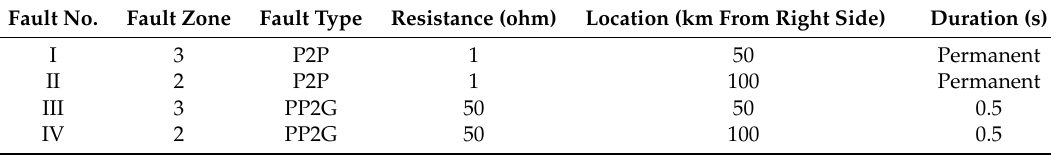
Table 2. Defined fault cases to apply on CIGRE DCS2 VSC-MTDC grid.